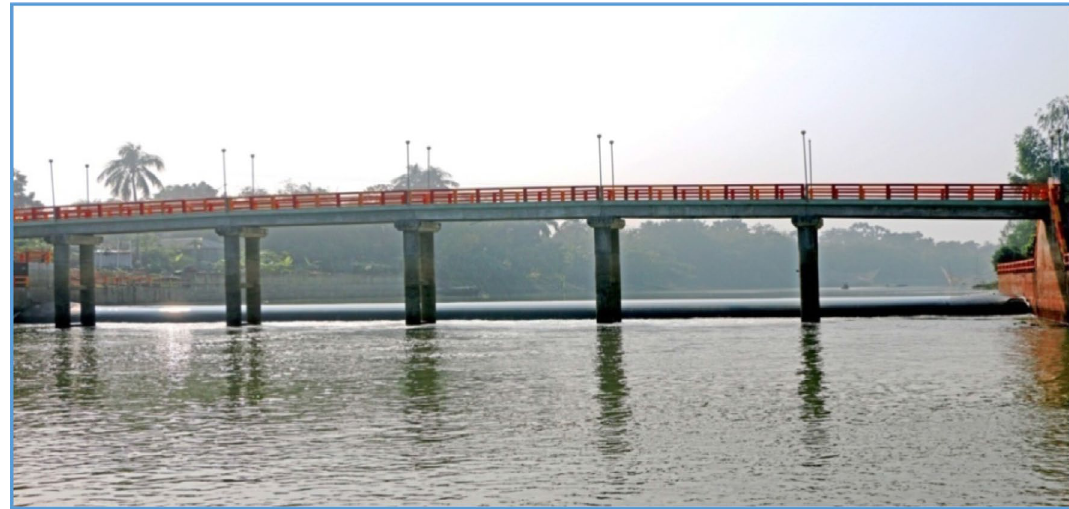
Fig. 3 A Rubber dam across the river Barnai at Jagodishpur, Puthia, Rajshahi